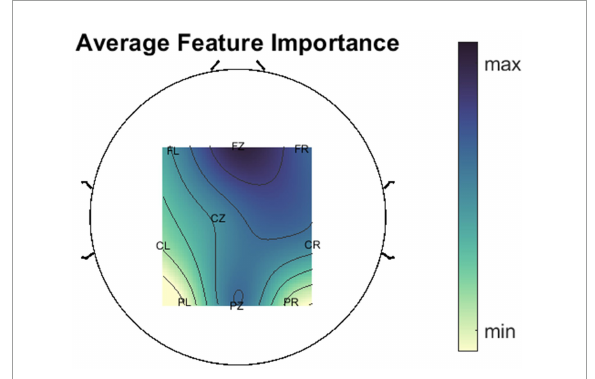
FIGURE8 Average ROI importance. The importance of CFC features belonging to a specific ROI for all low and high frequency band combinations were averaged providing this way a measure of ROI